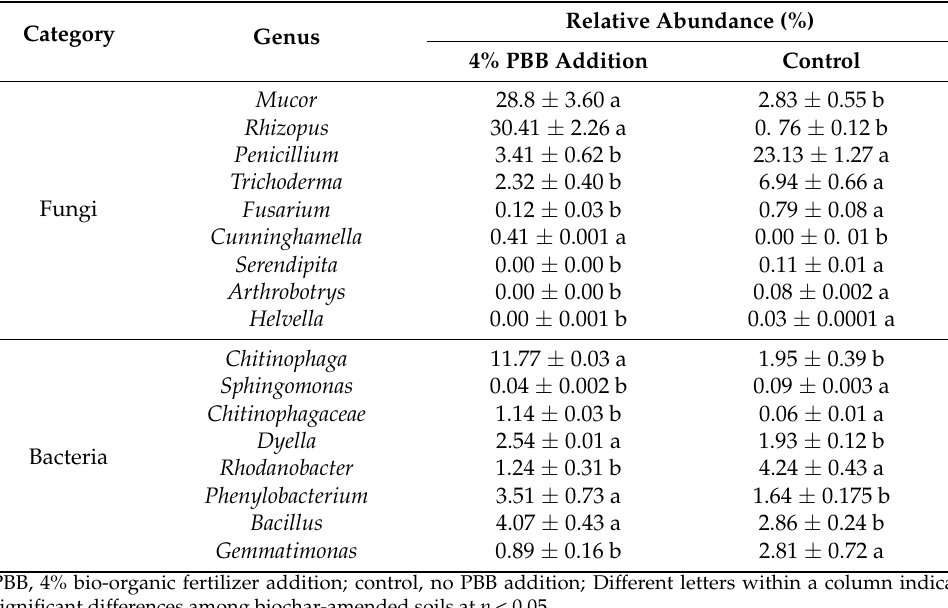
Table 5. Genera with significant differences in relative abundance between BOF addition and control.